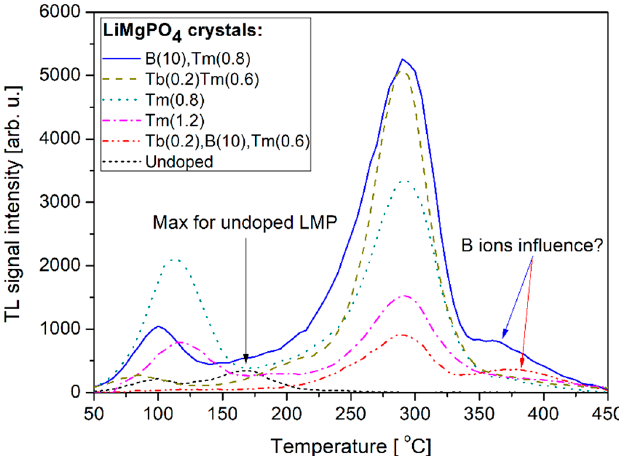
Figure 6. Comparison of the glow-curves measured for the studied LiMgPO 4 crystals irradiated with beta radiation. The numbers in brackets denote the concentrations of dopants and are given in